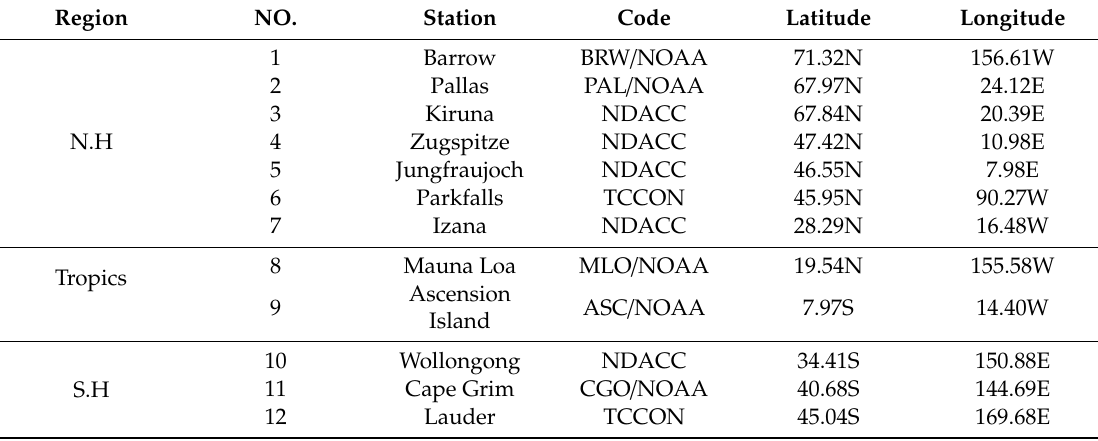
Table 2. List of stations from Detection of Atmospheric Composition Change (NDACC), Total Carbon Column Observing Network (TCCON), and National Oceanic and Atmospheric Administration (NOAA) / Global Monitoring Division (GMD) used for surface CH 4 trend analysis. Region